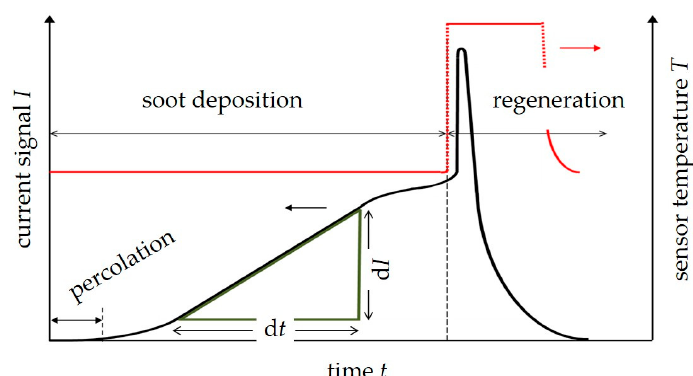
Figure 2. Typical shape of the sensor’s raw signal during one sensing cycle with increasing current I after a certain “blind” time before the percolation threshold is reached and a regeneration peak after increasing the sensor’s temperature for soot burn off. The regeneration peak is due to the increased soot conductivity when heating up. The slope of the linear increasing current during soot deposition, which is proportional to the conductance, often acts as the sensor signal.